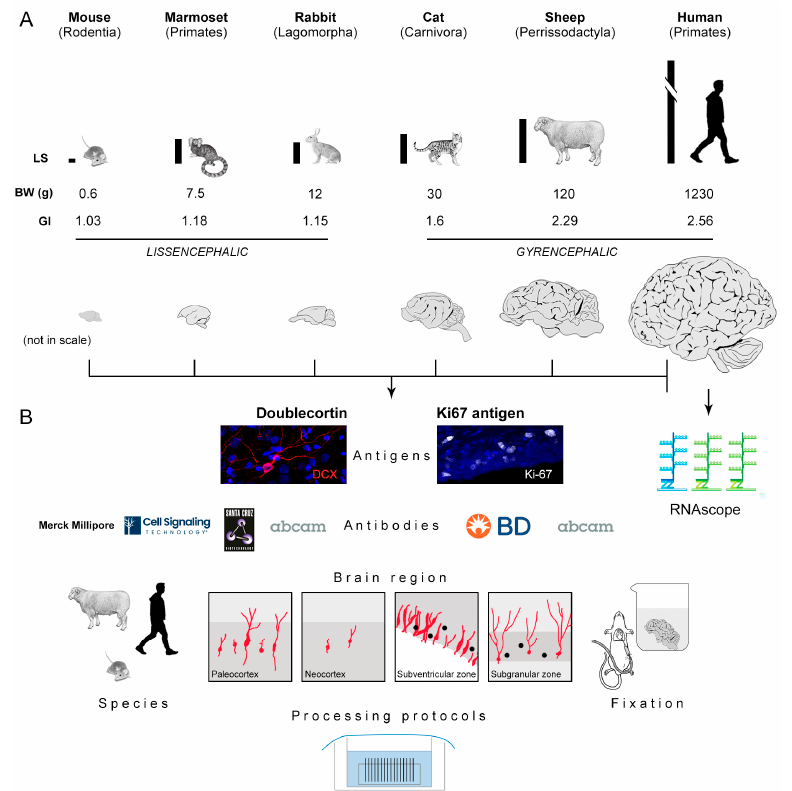
Figure 2. Experimental plan: ( A ) Animal species considered in this study, widely varying in brain size (BW: brain weight, in grams), gyrencephaly (GI: gyrification index) and lifespan (LS). ( B ) Schematic summary of the variables investigated; four brain regions are considered (squares: red cells, DCX; black dots, dividing nuclei). Logos reproduced with authorization of Companies.